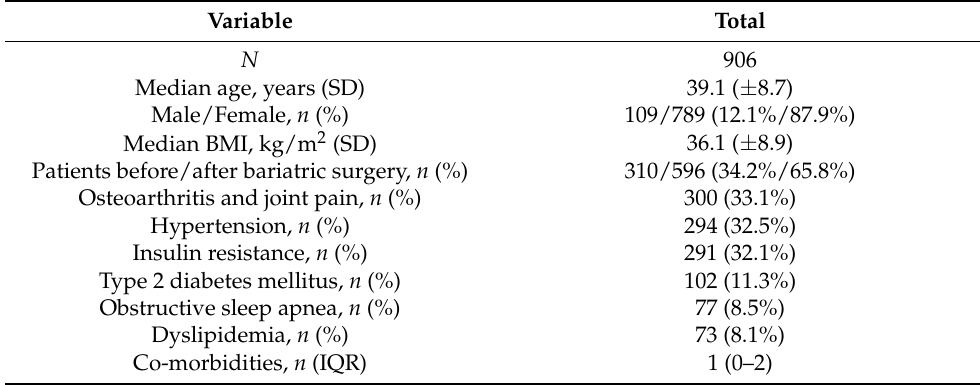
Table 1. Baseline characteristics of the study population.